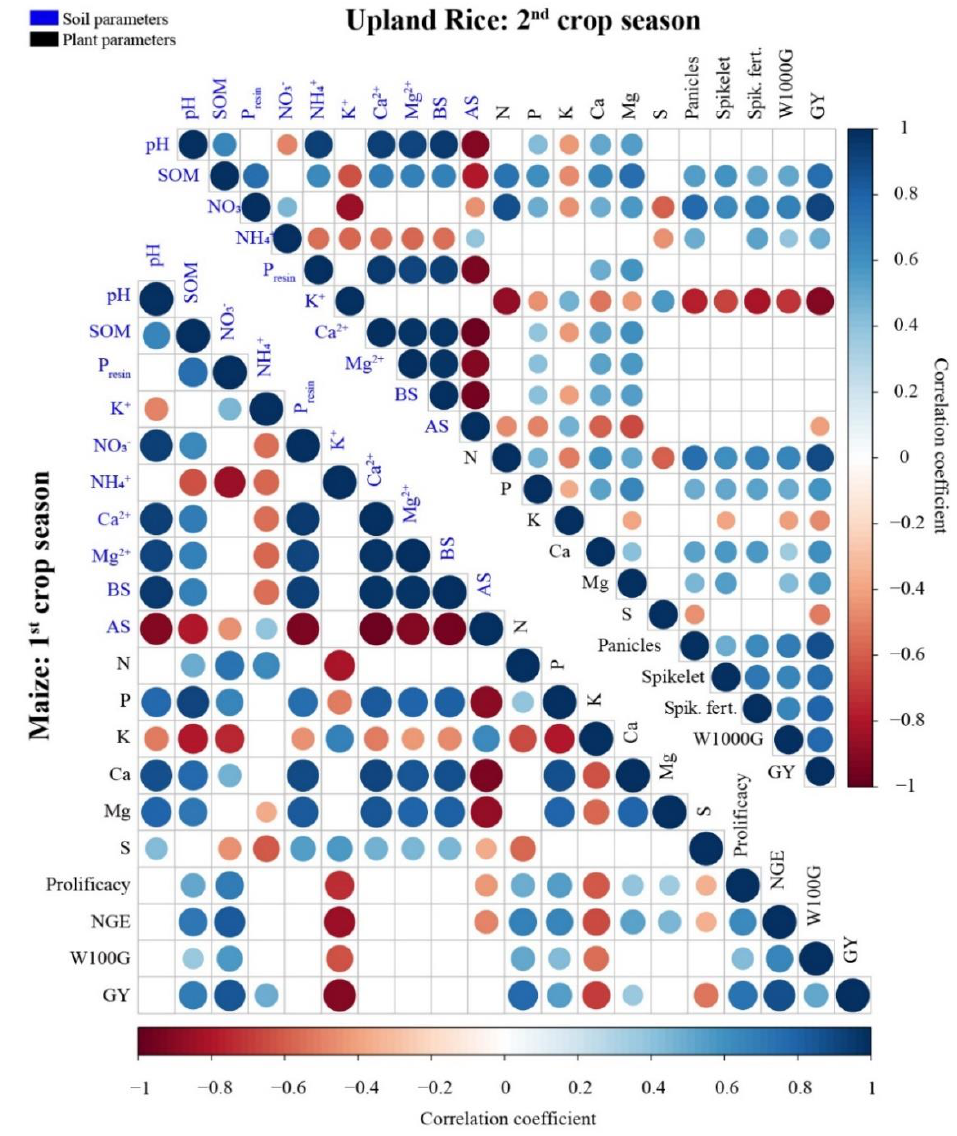
Figure 7. Heatmap of Pearson’s correlation based on soil chemical properties and agronomic parameters of maize and upland rice. Only significant correlations at p ≤ 0.05 are shown.